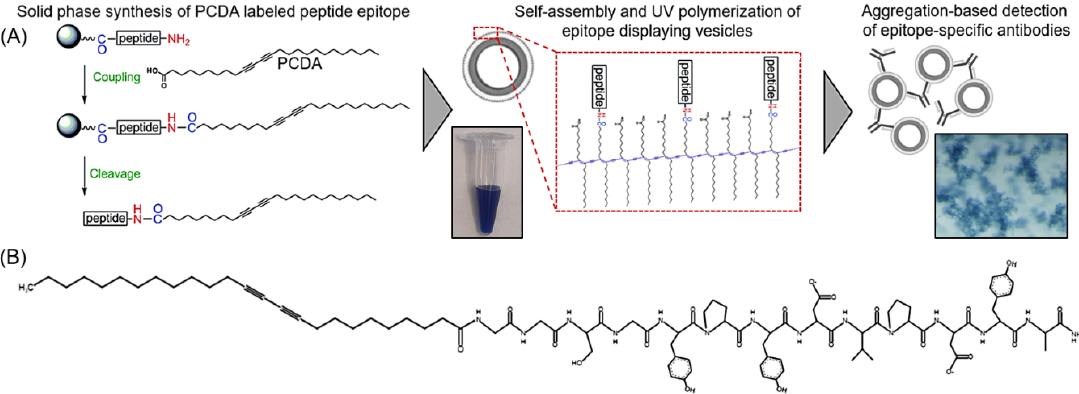
Figure 1. ( A ) Schematic overview of the process implemented in this work for generating a vesicle- based sensor with displayed hemagglutinin (HA) peptide epitope for the detection of epitope-spe- cific anti-HA antibodies. ( B ) Sketch of the synthesized HA peptide epitope appended to 10,12 pen- tacosadiynoic acid (PCDA) via a Gly-Gly-Ser-Gly spacer segment.